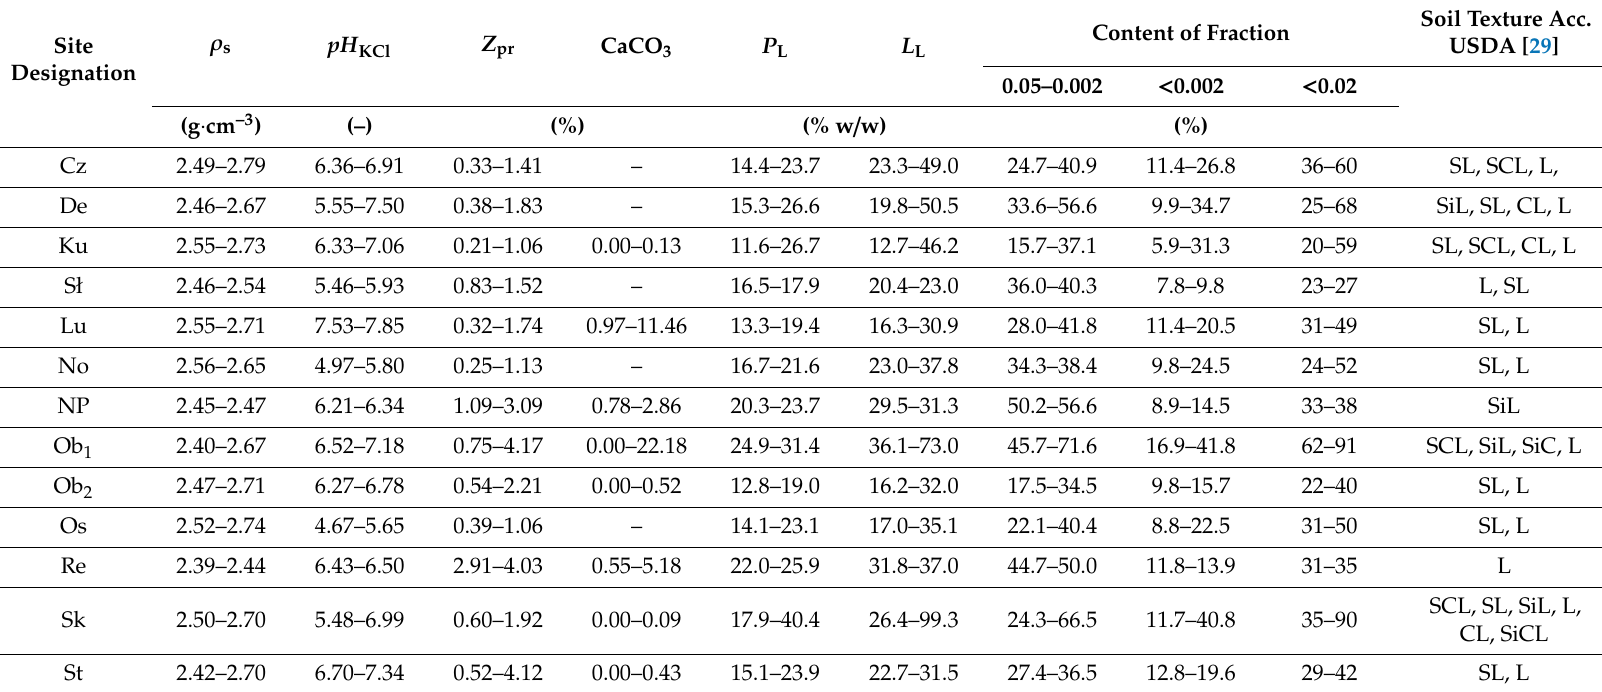
Table A1. Ranges of properties of researched soils for individual sites in layer of 25–60